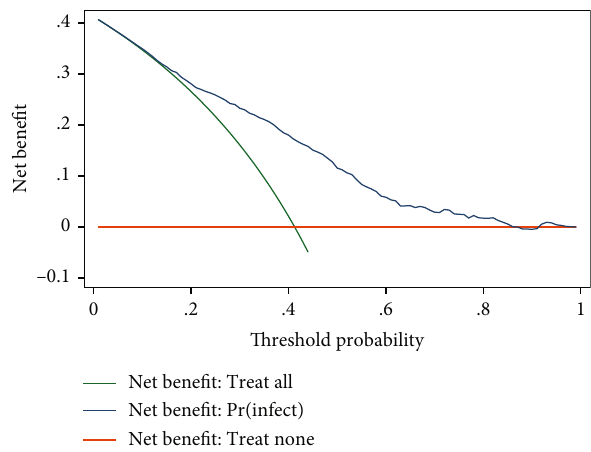
Figure 4: Decision curve analysis for the nomogram. The y -axis measures the net bene fi t. The blue line represents the nomogram. The green line represents the assumption that all patients have extended operation time. The pink line represents the assumption that no patients have extended operation time. The decision curve showed that if the threshold probability of a patient or doctor is > 18%, using the nomogram in the current study to predict extended operation time adds more bene fi t than the treat-all- patients scheme or the treat-none